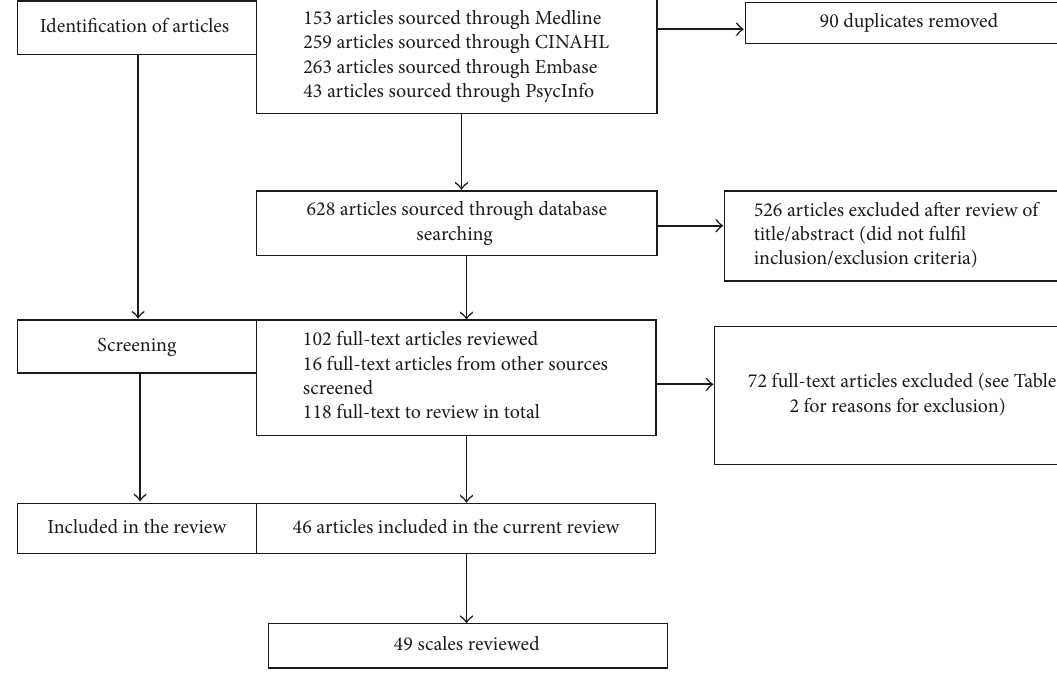
Figure 1: PRISMA flow diagram of study selection process.